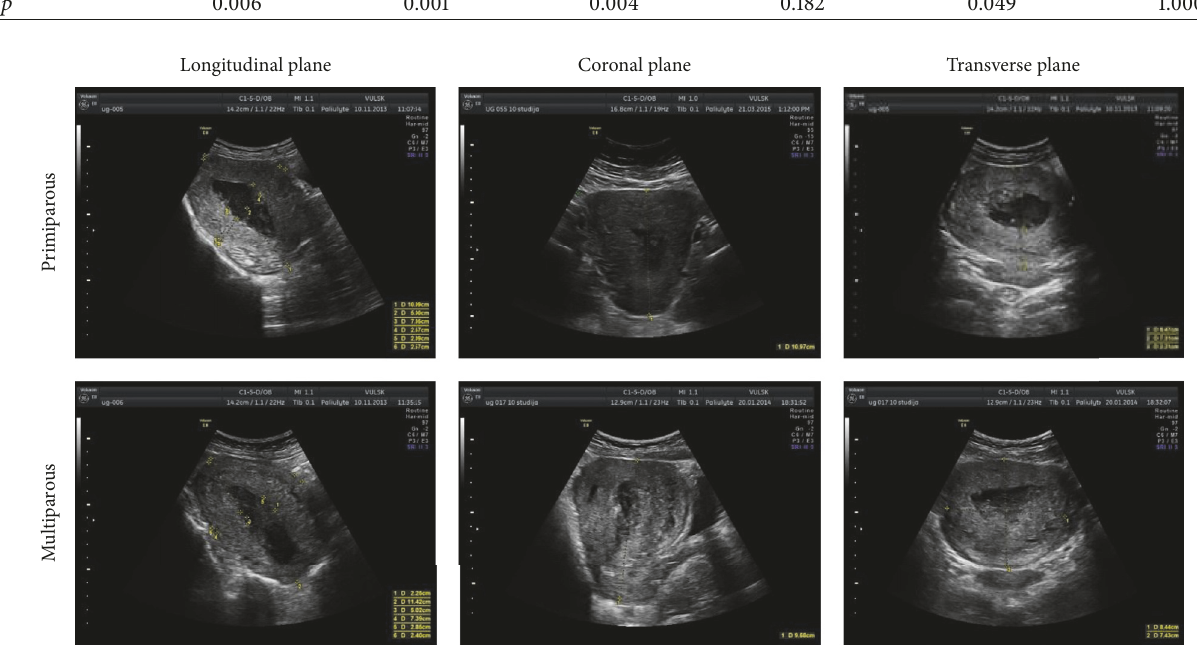
Figure 11: Most frequent uterine cavity inserts in all planes on the 10th day (primiparous and multiparous).